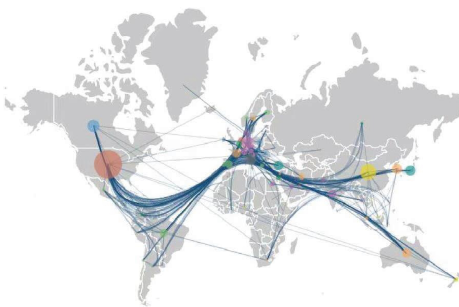
Figure 7: Cooperation network map of